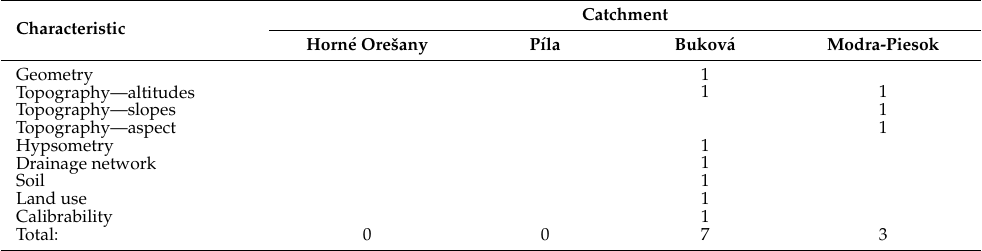
Table 6. Evaluation of the similarity of catchments using penalization.